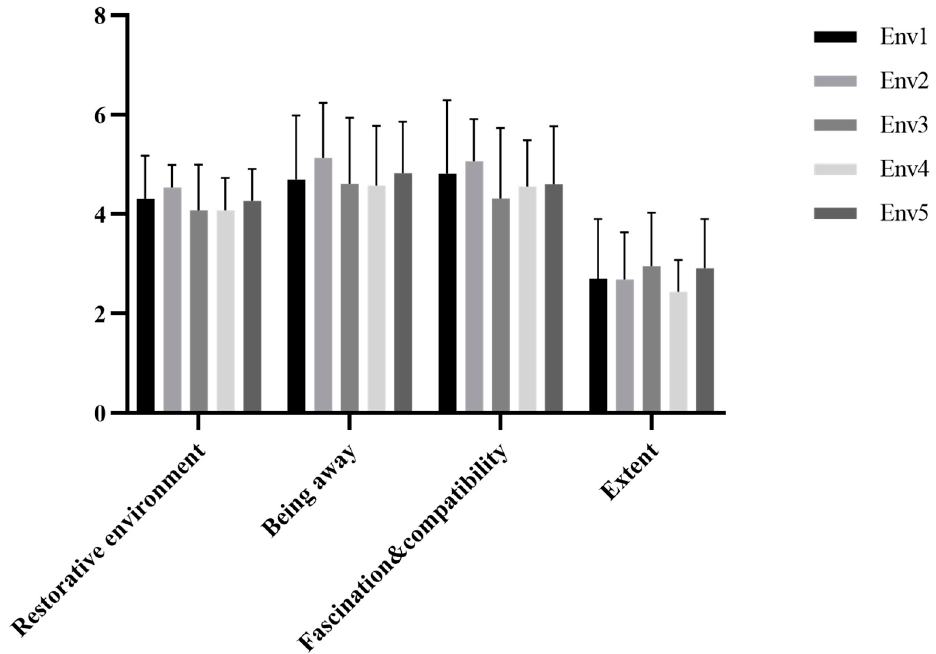
Figure 13. Descriptive statistical results of the restorative environment and each dimension. Interpretation: Env1, VR urban environment visual experiencing group; Env2, VR restorative environment visual experiencing group; Env3, VR restorative environment interactive experiencing group; Env4, VR restorative environment with fishing interaction group; Env5, VR restorative environment with watering interaction group.